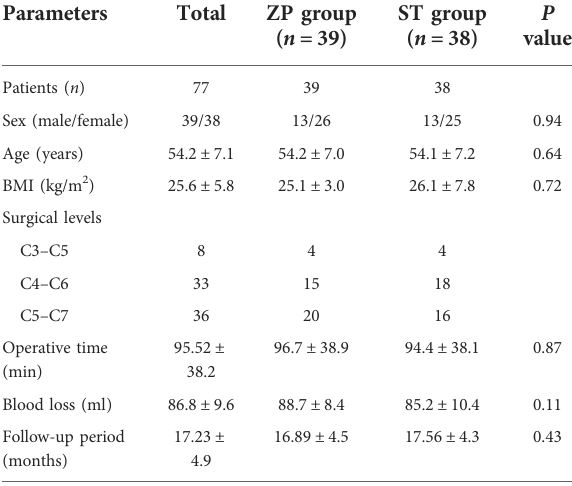
TABLE 2 Demographic outcomes of patients and clinic outcomes.